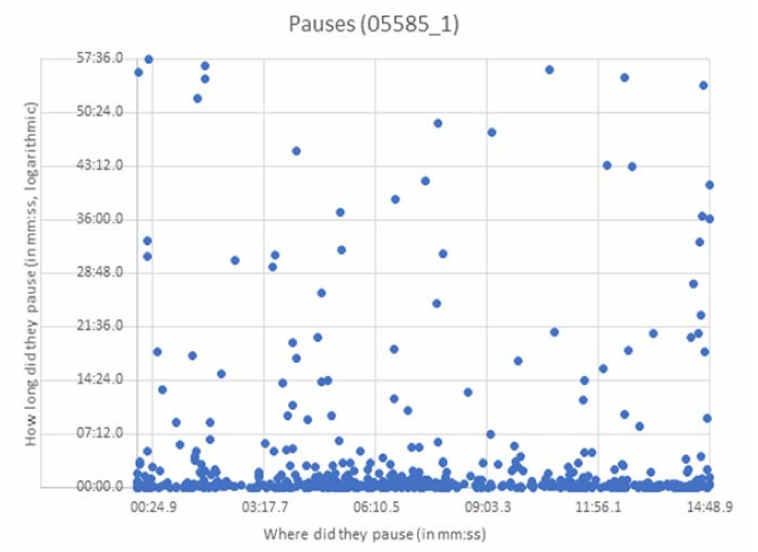
Figure 4. A scatter plot representing pausing behaviour for a typical